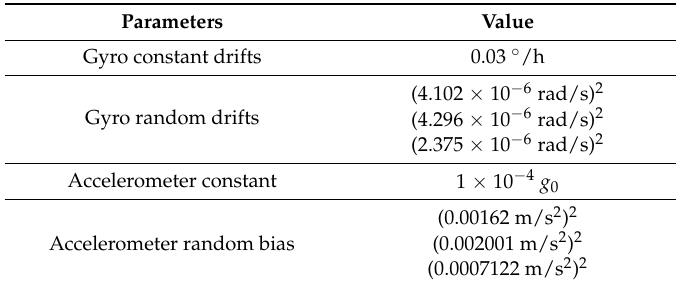
Table 4. The practical measured data.